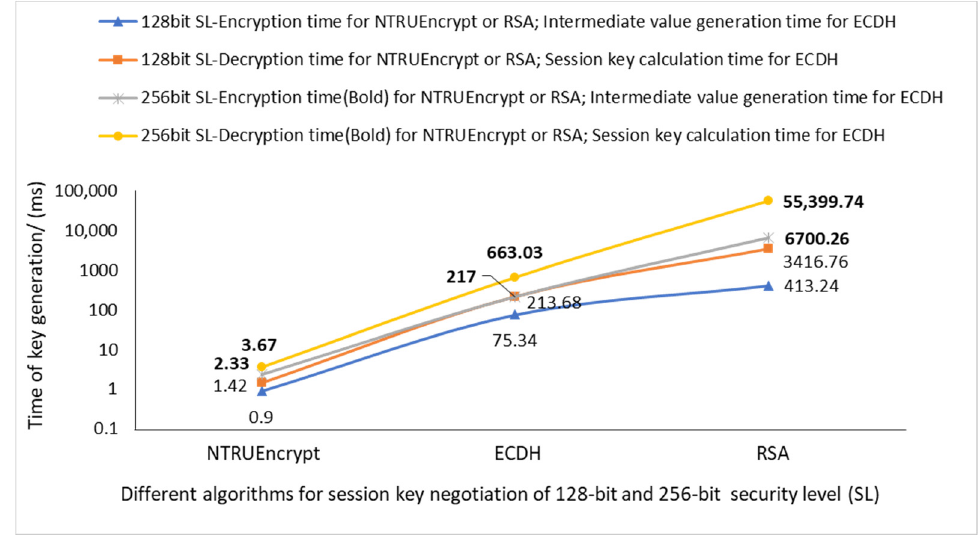
Figure 5. Time consumption comparison of encryption and intermediate value generation, decryption, and session key calculation.